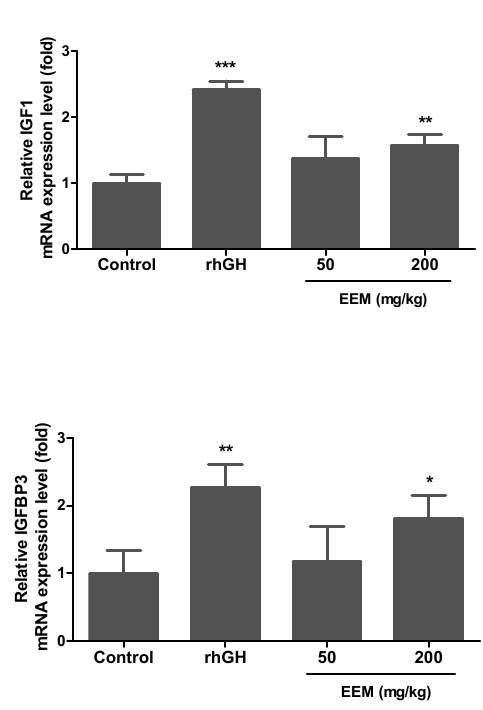
Figure 6. Relative expressions of IGF1 and IGFBP3 mRNA in liver. The relative transcription levels of IGF1 ( A ) and IGFBP3 ( B ) were analyzed by applying to GAPDH internal control; * p < 0.05, ** p < 0.01, *** p < 0.001.